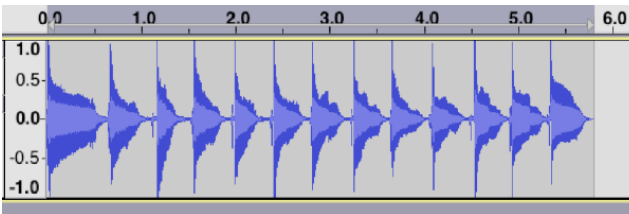
Fig. 15. Group III’s timing for 13 note actuation